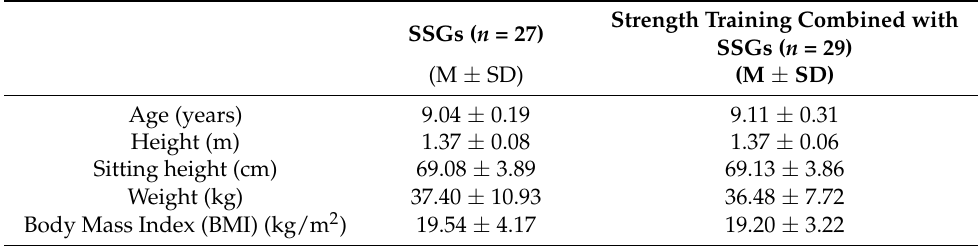
Table 2. Information of subjects about age, height, sitting height, weight, and body mass index (BMI) according to groups (small-sided games (SSGs) or strength combined with small-sided